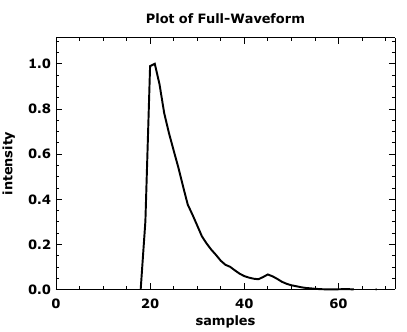
Figure 6. Example for stacked full-waveform.